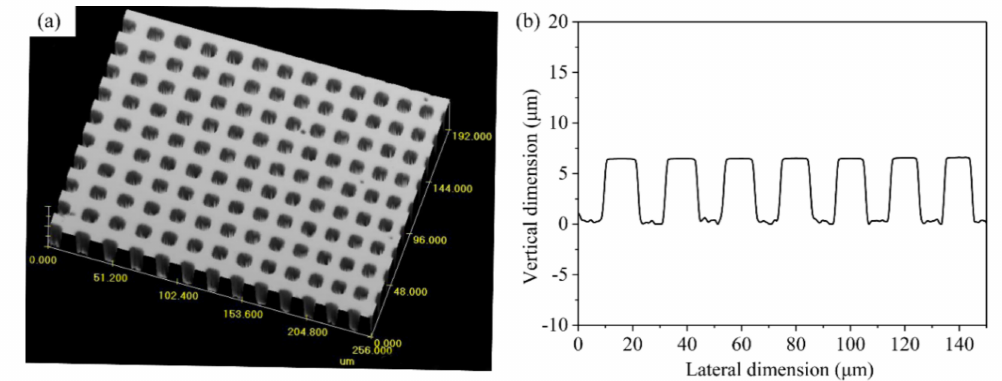
Figure 2. ( a ) 3D LSCM images of the negative structure arrays (NSAs); ( b ) the profile picture corresponding to ( a